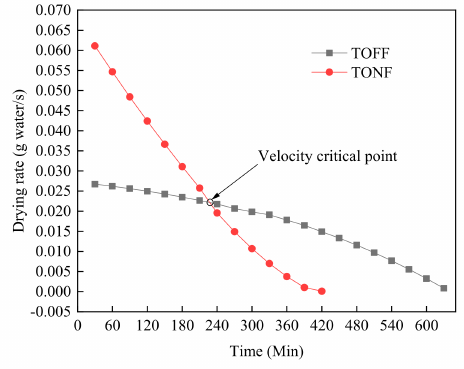
Figure 9. Changes of carrot moisture drying speed with